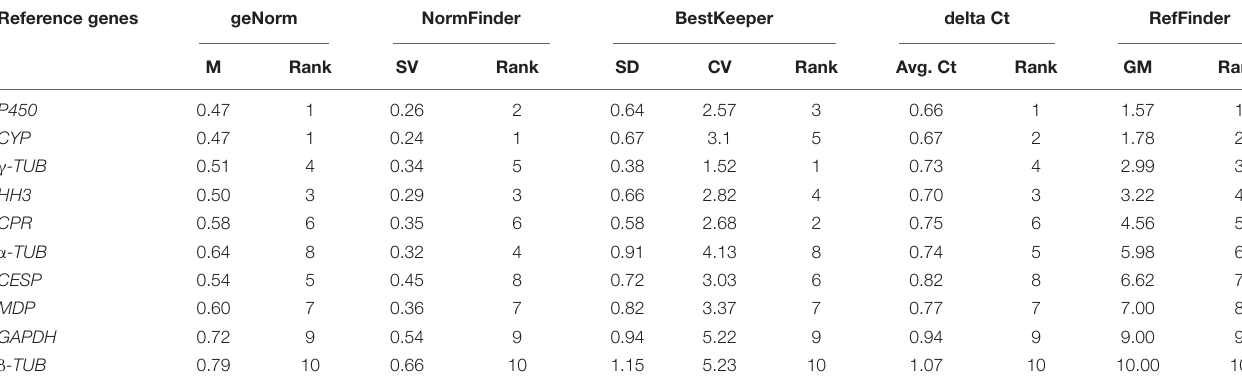
TABLE 2 | Expression stability ranking of the 10 candidate reference genes based on five algorithms. Reference genes geNorm NormFinder BestKeeper delta Ct RefFinder